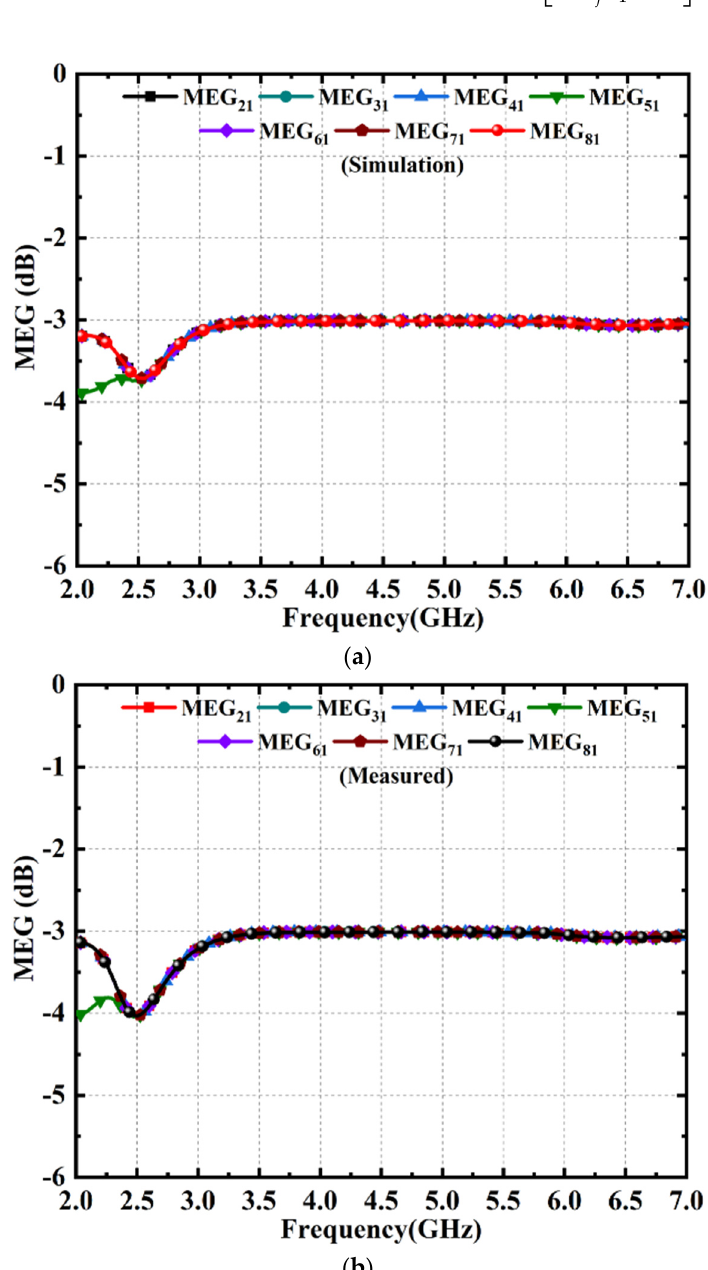
Figure 19. MEG response: ( a ) simulated and ( b ) measured.